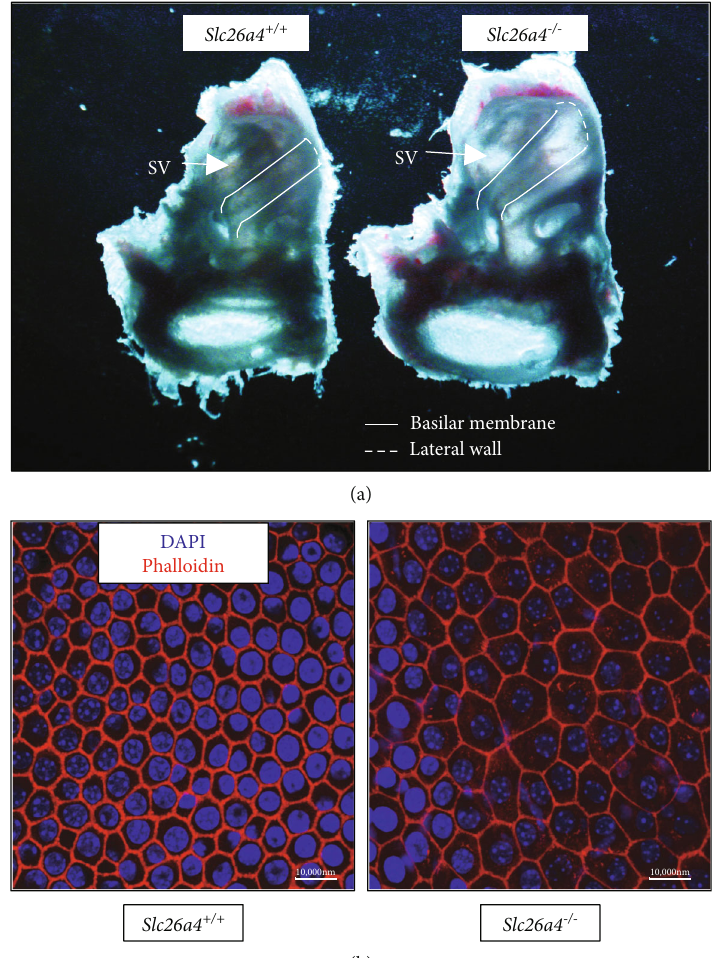
Figure 1: The dramatic morphological changes occurred in stria vascularis from Slc26a4 -/- mice. (a) The scala media, formed by basilar membrane, lateral wall, and vestibular membrane, is signi fi cantly enlarged in Slc26a4 -/- mice. SV: stria vascularis. The outline of stria vascularis, which is visualized through pigmentation in intermediate cells, is clearer in Slc26a4 +/+ mice. (b) Marginal cells in stria vascularis from wildtype or Slc26a4 -/- mice were coated on coverlips and sent for phalloidin